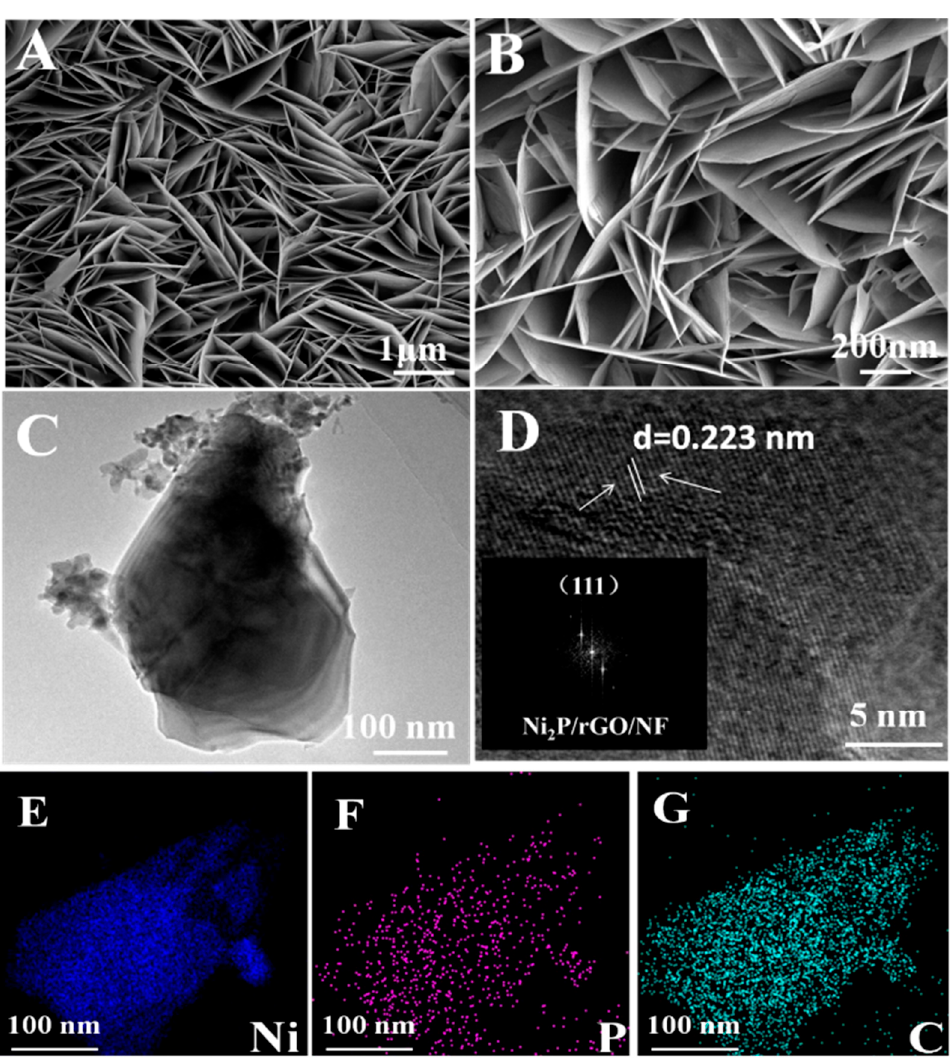
Figure 4. ( A , B ) Scanning Electron Microscopy (SEM); ( C ) Transmission Electron Microscopy (TEM); ( D ) High-Resolution Transmission Electron Microscopy (HRTEM) (inset: fast fourier transform (FFT) of Ni 2 P/rGO/NF); and ( E-G ) Element mapping of Ni 2 P/rGO/NF.